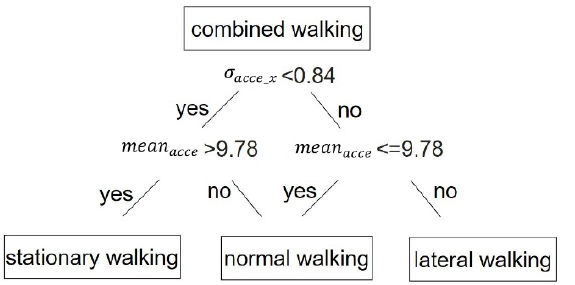
Figure 4. The flow chart of DT-based classification for normal walking, stationary stepping, and lateral walking. Table 6. The performance of DT classifier.